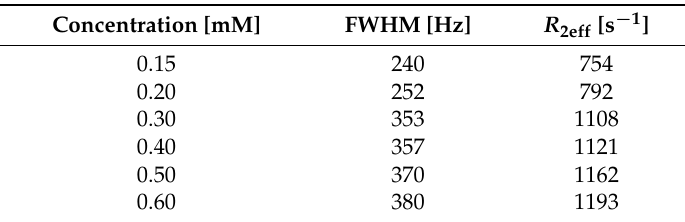
Table 1. The dependence of the 1 H nuclear magnetic resonance line widths vs of nanomaterial B and effective relaxation rates R 2eff as obtained from the line